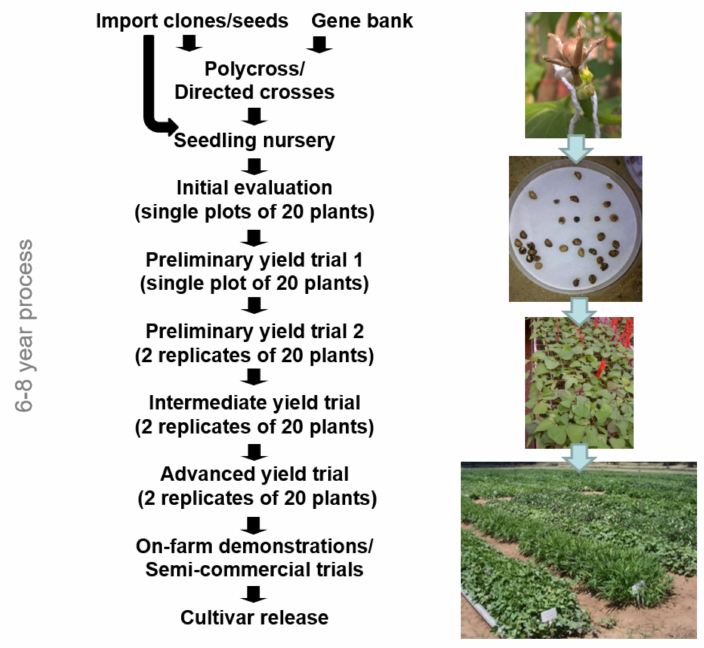
Figure 9. Schematic representation of the breeding